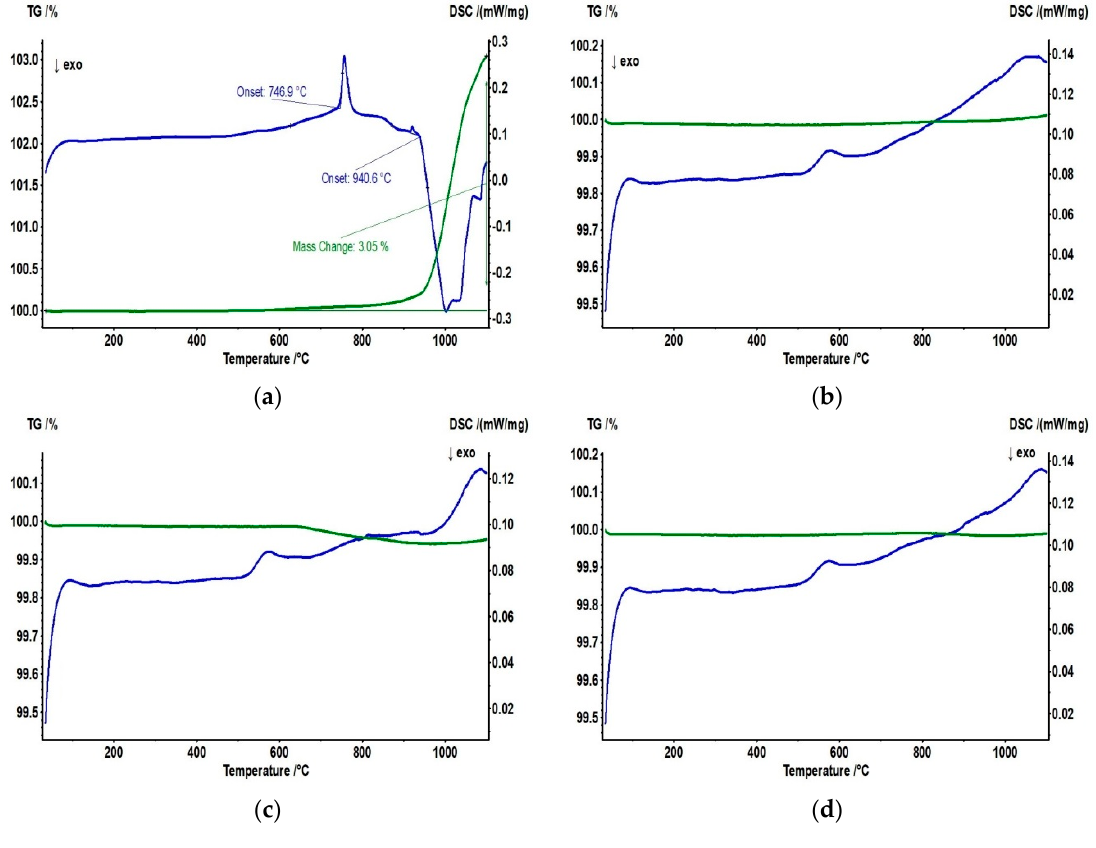
Figure 4. DSC/TG curves measured for the samples: ( a ) 16Mo3 steel, ( b ) pure NiCr, ( c ) NiCr-Re and ( d ) NiCr-Re-Al 2 O 3 .